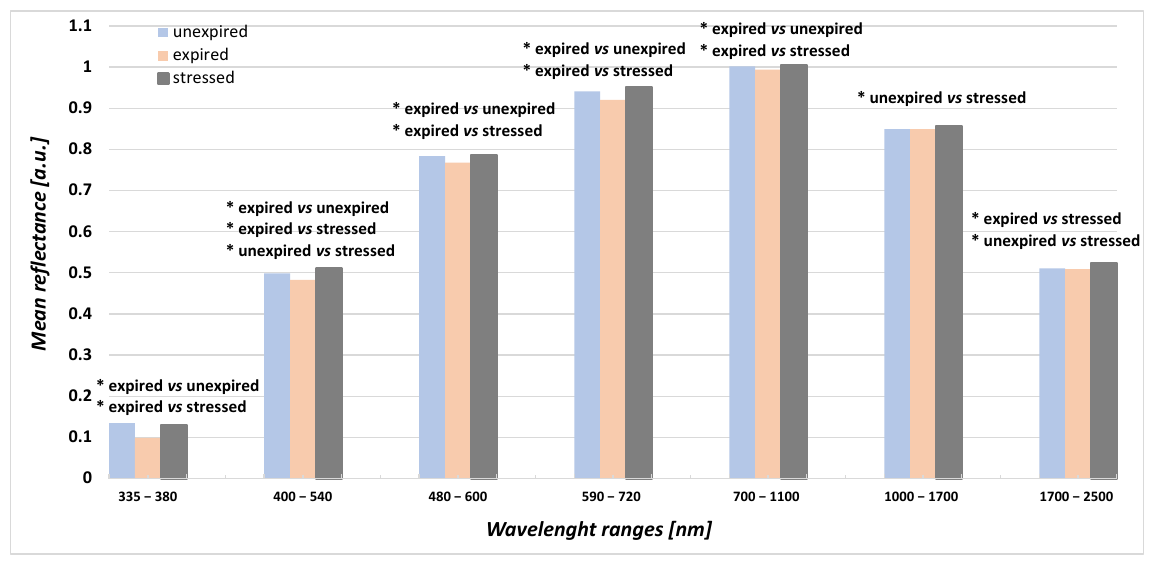
Figure 1. Differences in the mean total reflectance values between the tested tablets at different wavelength ranges (post hoc analyses). * Statistically significant difference at p < 0.020.